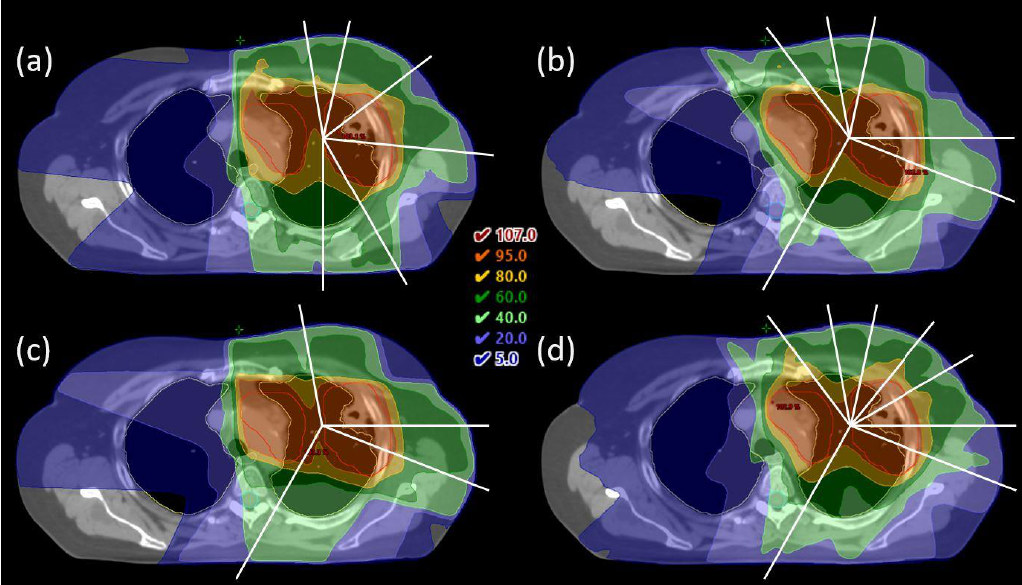
Figure A1. ( a ) CLIN plan with manually selected beam angles for patient 4, with a frontal tumor and lymph nodes. ( b – d ) iCE plans with 6, 4 and 8 optimized beam angles for the same patient. Dose is shown relative to the prescribed dose (66 Gy). Contours are the PTV (red), lungs (yellow), esophagus (grey) and spinal cord (cyan), and beam angles are indicated by white lines. For this patient, the optimized beam angles in the 6- and 8-beam plans enabled sparing of the esophagus.